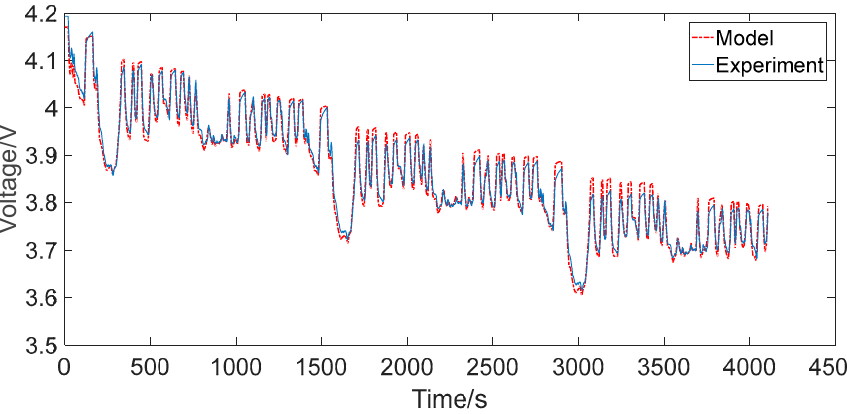
Figure 15. The simulation output of the second-order RC model for the UDDS cycle.